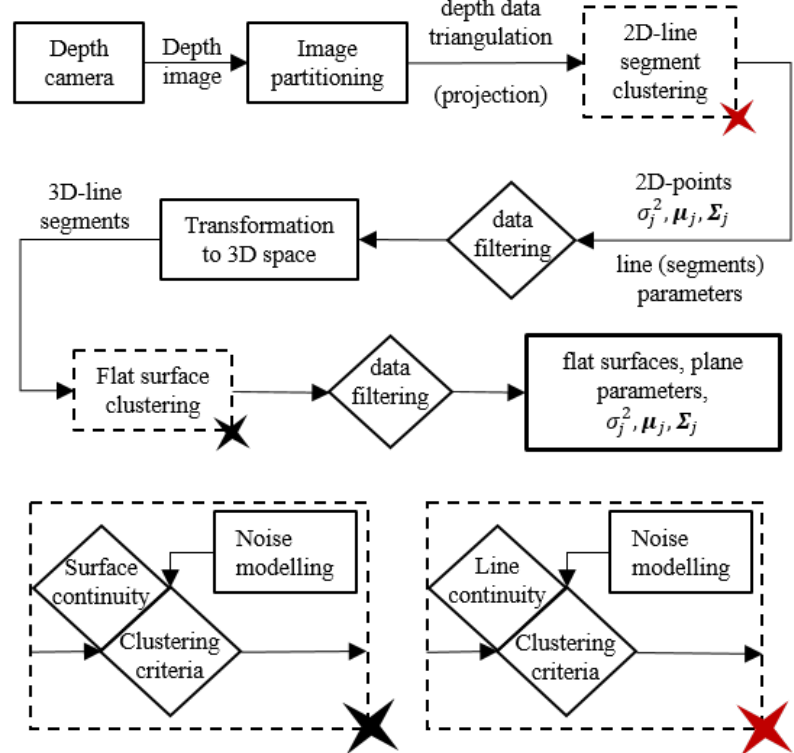
Figure 2. An overview of the EPCC-based